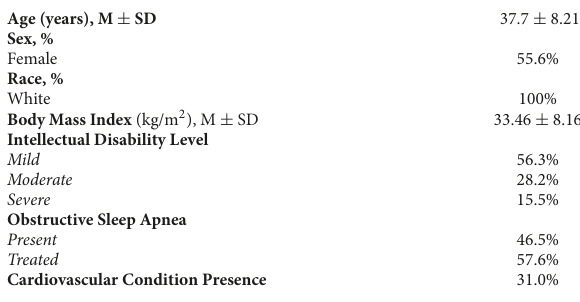
TABLE 1 Participant demographic characteristics ( N =